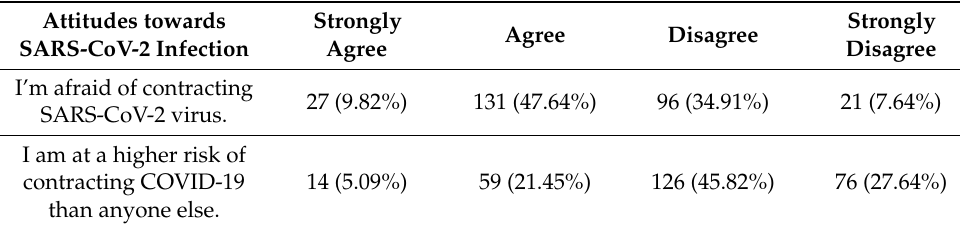
Table 3. Attitudes of nursing, midwifery, and emergency medical services students towards SARS- CoV-2 infection. Attitudes towards